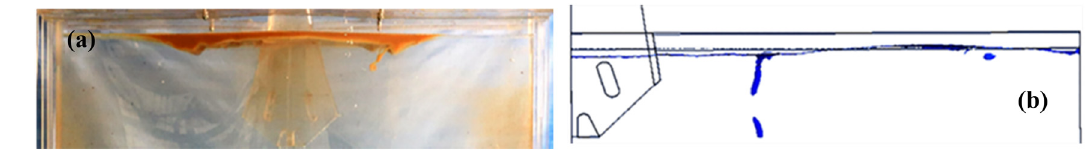
Figure 10: Funnel mold liquid level slag entrapment diagram: ( a ) physical simulation and ( b ) numerical simulation ( 30 s ) .